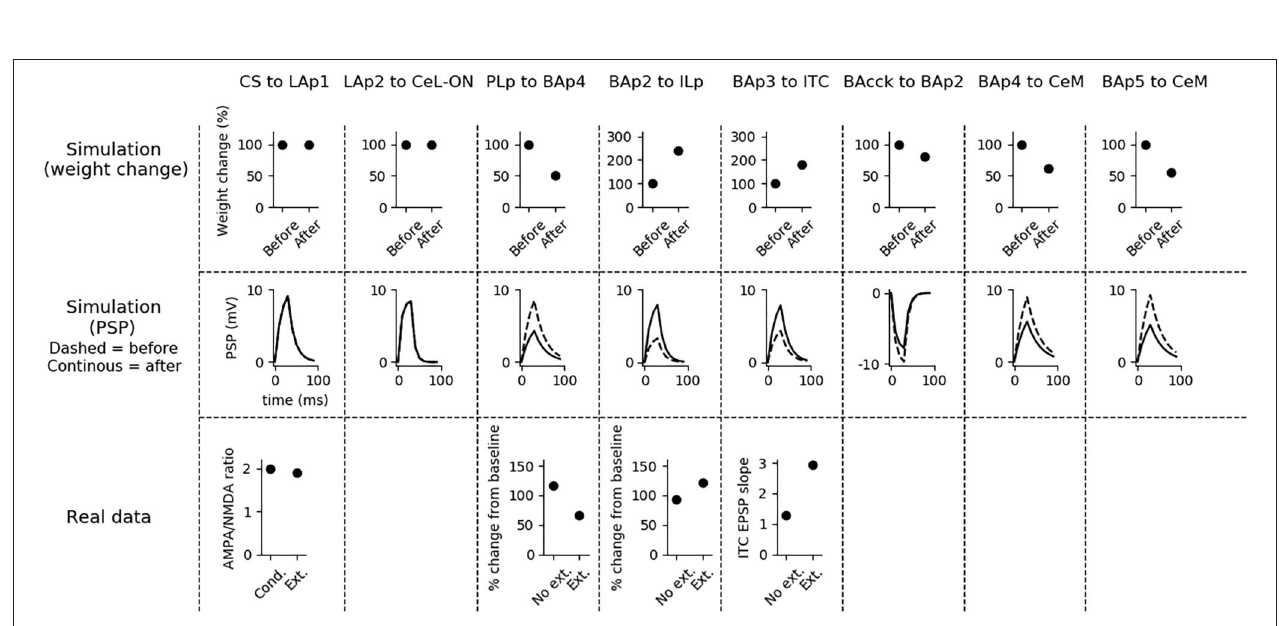
FIGURE 5 | Changes in connection weights and PSP before and after fear extinction. First row: simulated connection weights before and after fear extinction. Second row: simulate effect of a 30 ms presynaptic stimulation on the PSP of the plastic connections of the model (the presynaptic stimulation was adjusted to obtain a change of maximum 10 mV in the postsynaptic unit). Third row: real data (Vouimba and Maroun, 2011) showing that, as in simulation, the mPFC-induced activation of BA decreases after extinction whereas the BA-induced activation of mPFC increases; moreover, as reported by Amano et al. (2010), BA stimulation evokes a higher EPSC slope in ITC neurons after extinction. On the other hand, AMPA/NMDA ratio at the synapse between the CS pathway and LA does not change (Kim and Cho, 2017). The other simulated synapses shown here to be stable have never been reported in the literature to undergo LTP or LTD during fear extinction.